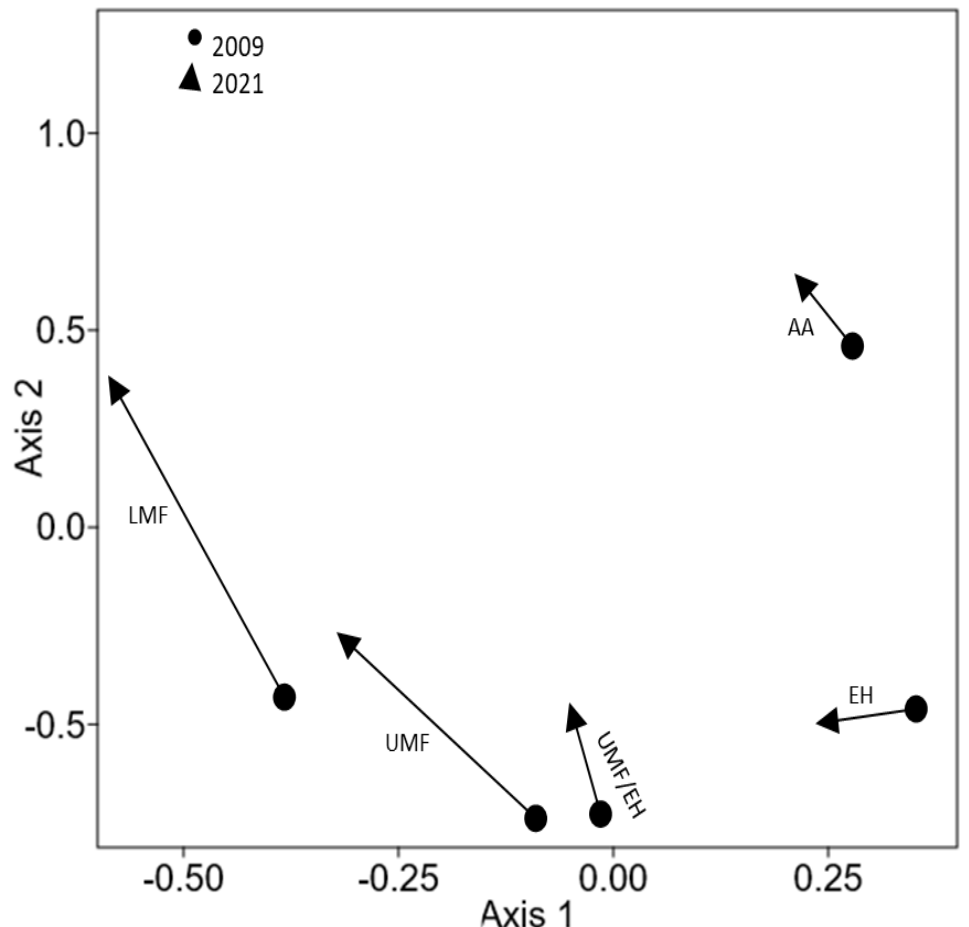
Figure 7. Elevational shifts in the community composition of small mammals on Mount Meru. Arrows indicate the degree of change in species composition between 2009 and 2021, based on the PCoA matrix. Axis 1 and Axis 2 refers to the PCoA 1 and PCoA 2 axis respectively. LMF (lower montane forest); UMF (upper montane forest); UMF/EH (upper montane forest/Ericaceous heathland); EH (ericaceous heathland); and AA (Afroalpine).